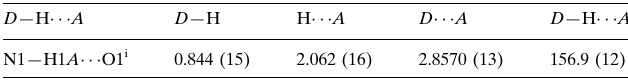
Hydrogen-bond geometry (A˚ , (cid:4)